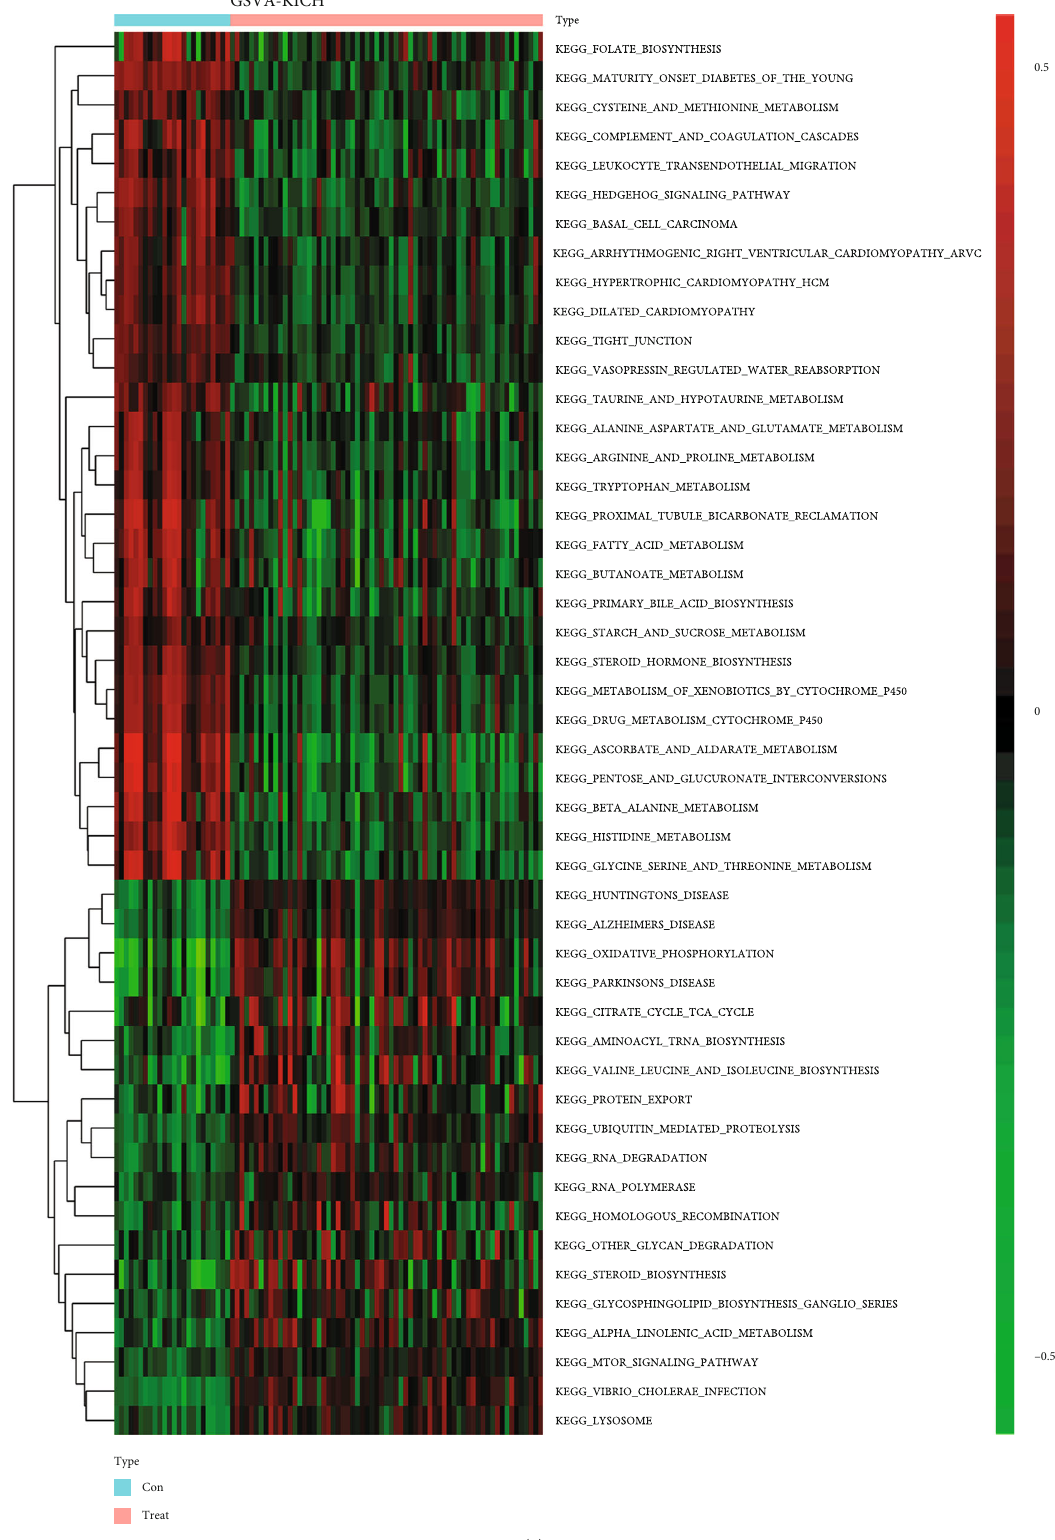
Figure 1: Overview of GSVA in pan-renal cell carcinoma. (a) KIRC, (b) KIRP, and (c) KICH. The redder the color, the stronger the activation of the corresponding pathway. The greener the color, the stronger the suppression of the relevant